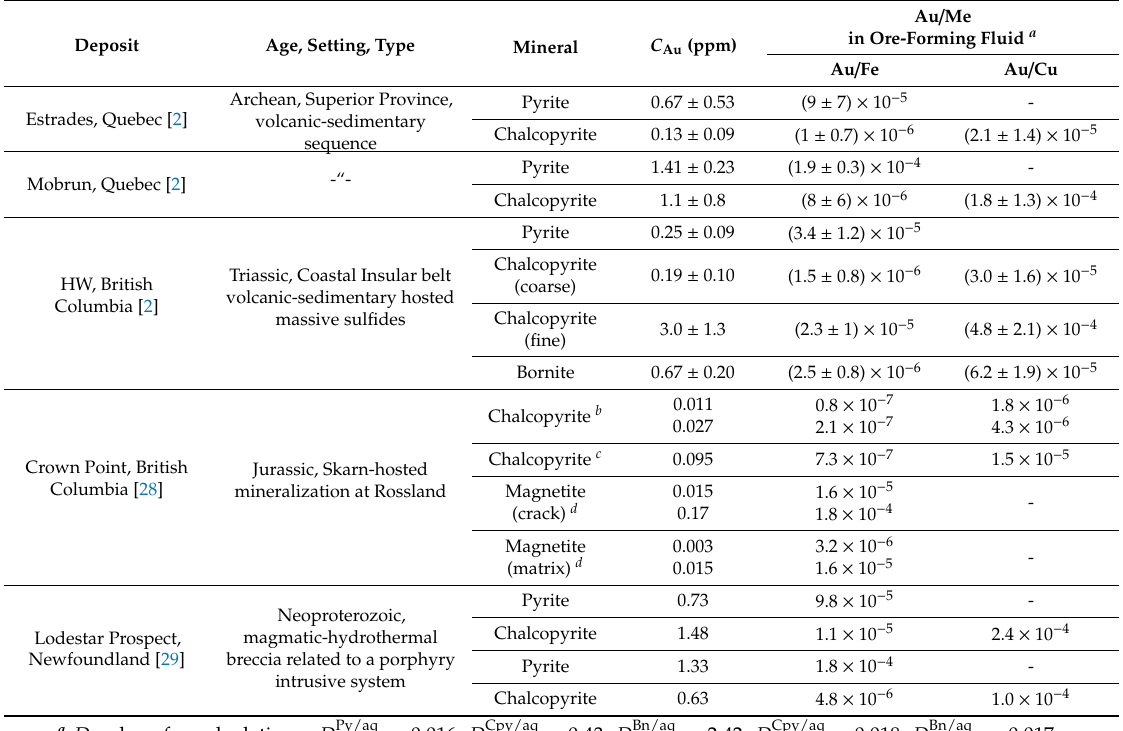
Table 8. Concentration of invisible gold in selected sulfide minerals [2,28,29] and calculated Au / Me ratios in mineral-forming